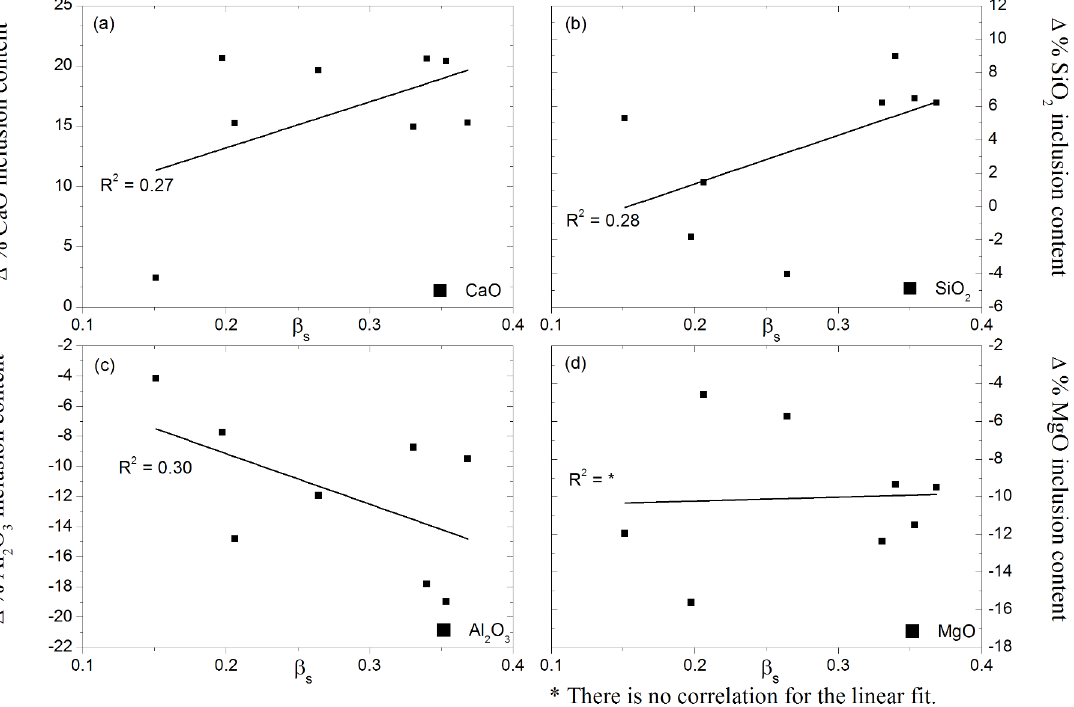
in inclusion content change in (a) CaO, (b) SiO